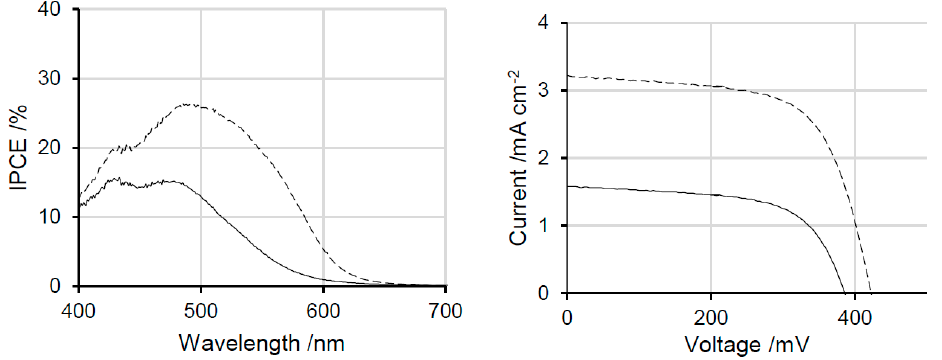
Figure 3. IPCE spectra and J – V curves of DSSCs based on photochemically (solid line) and thermally (dashed line) modified TiO 2 electrodes by DSBTPz . Reproduced from Reference [29]—Published by the Royal Society of Chemistry.